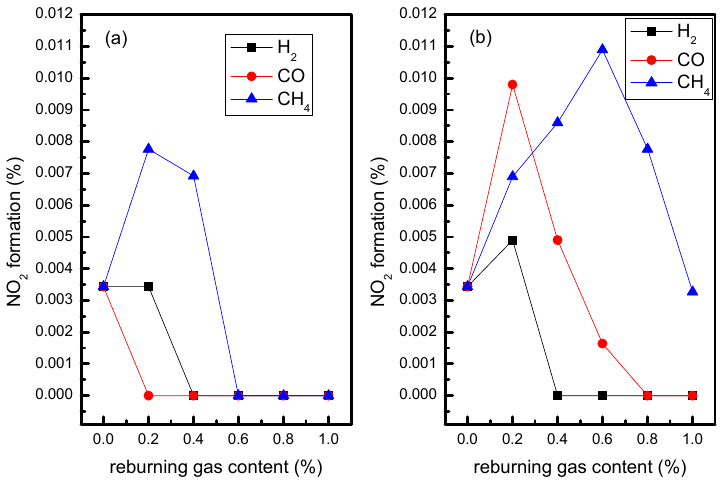
formation and reburning gas content: ( a ) Homogeneous 2 O decomposition with circulating ash as bed 2 O/N , 900 2 2